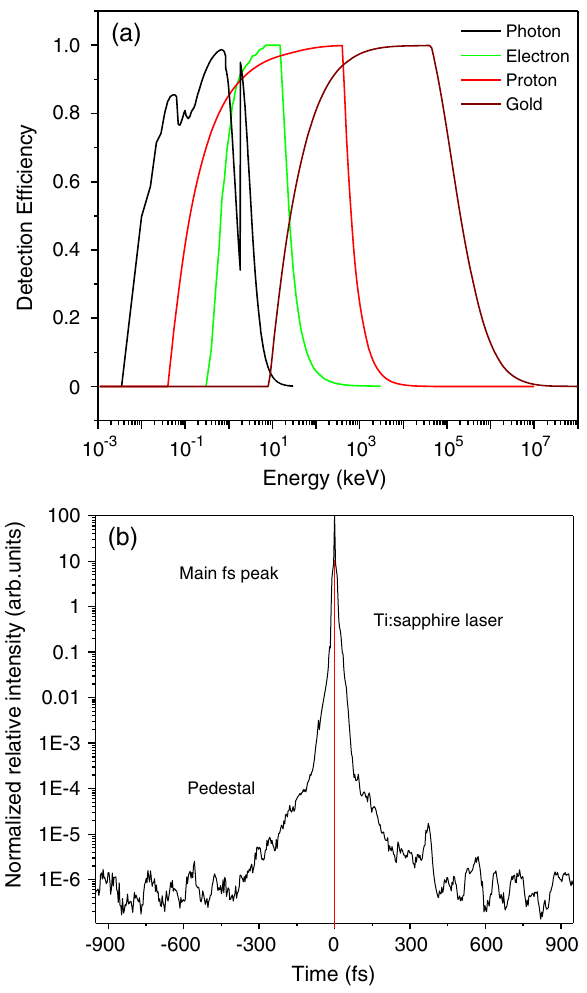
FIG. 2. Detection efficiency as a function of the energy and of the kind of radiation (a) and shape of the fs laser pulse vs time